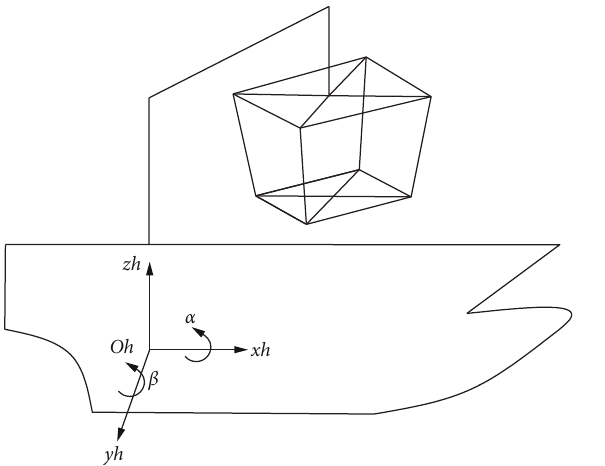
F IGURE 4: Schematic diagram of rescue vessel with antiswing device for hanging basket.